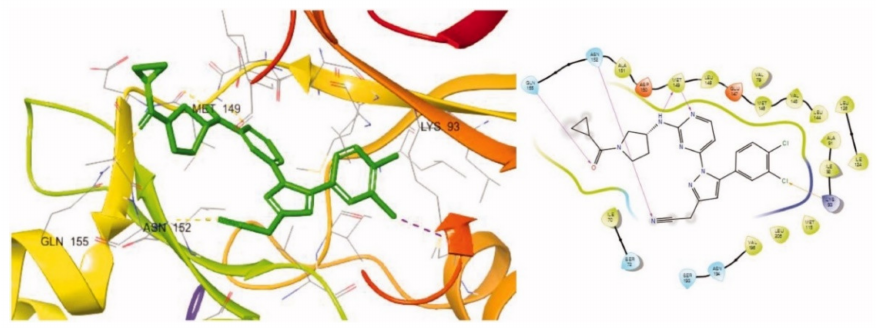
Figure 55. Putative binding mode of compound 47 with JNK3 crystal structure [61].